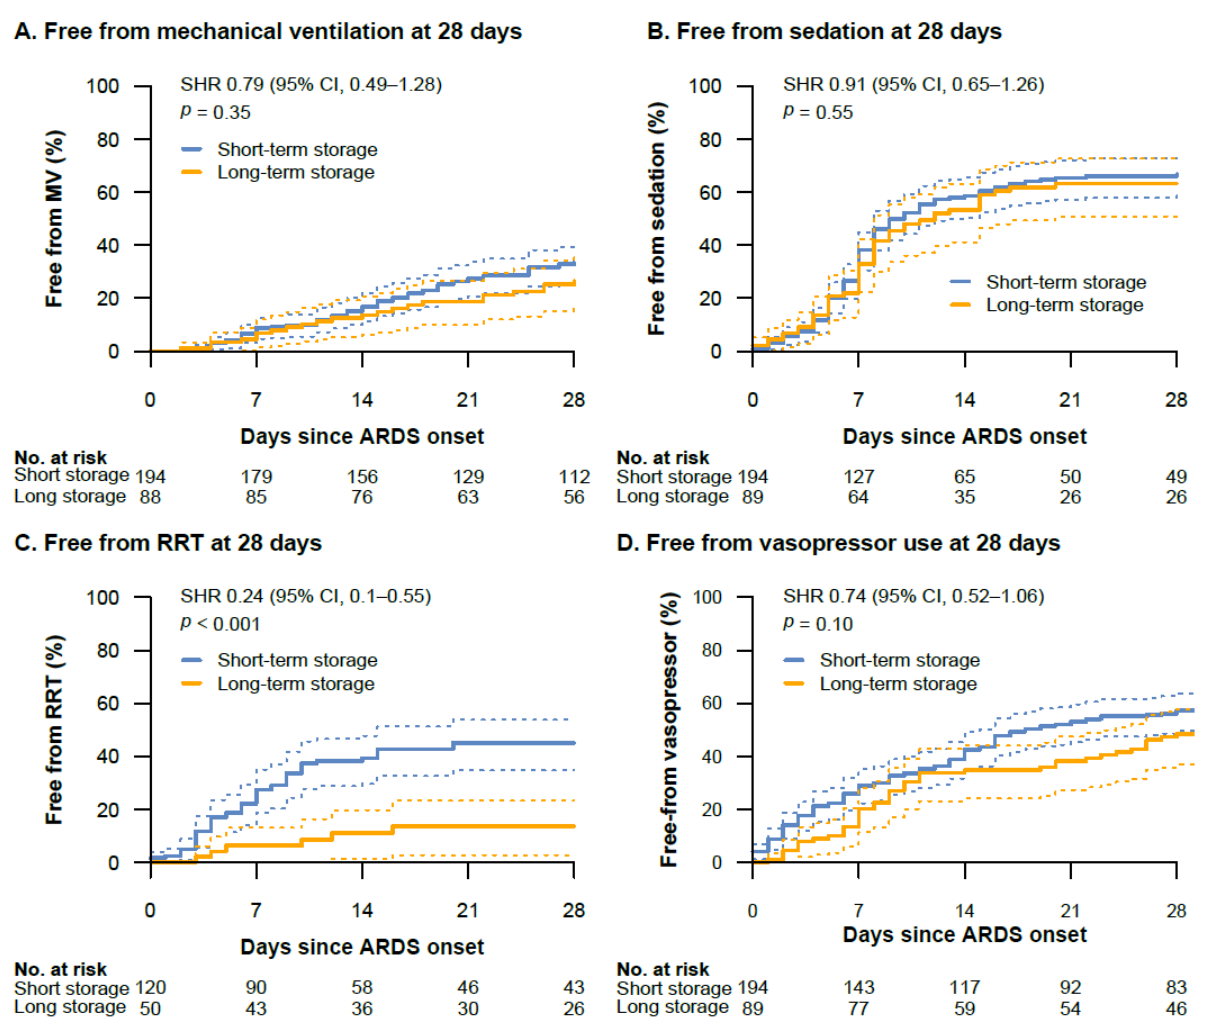
Figure 4. Cumulative incidence curves with 95% confidence intervals (dotted lines) of ventilator- free ( A ), sedation-free ( B ), RRT-free ( C ), and vasopressor-free ( D ) days composites between the short-term and long-term storage groups. The subdistribution hazard ratio (SHR) is provided with 95% confidence intervals. The SHR of the RRT-free days composite was adjusted for the presence of chronic kidney disease. One patient in the long-term storage group did not receive invasive mechanical ventilation during ARDS treatment and was therefore not included in the analysis of the ventilator-free days composite. Definition of abbreviations: MV = mechanical ventilation.